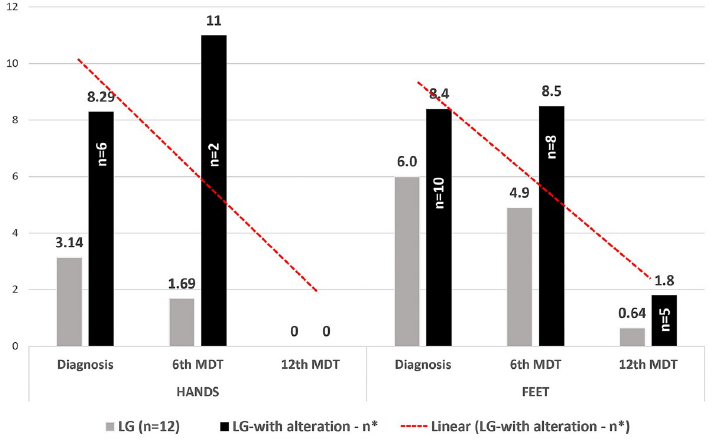
Fig 3. Averages of the number of altered points in feet and hands in the leprosy group (LG) and among only altered patients (LG–with alteration). n � = number of patients being followed up in the LG at diagnosis and in the 6 th MDT (n = 12) and 12 th MDT (n = 11) and patients with altered sensitivity in the hands and feet respectively: n = 7/2/0 in the hands and n = 10/8/5 in the feet.